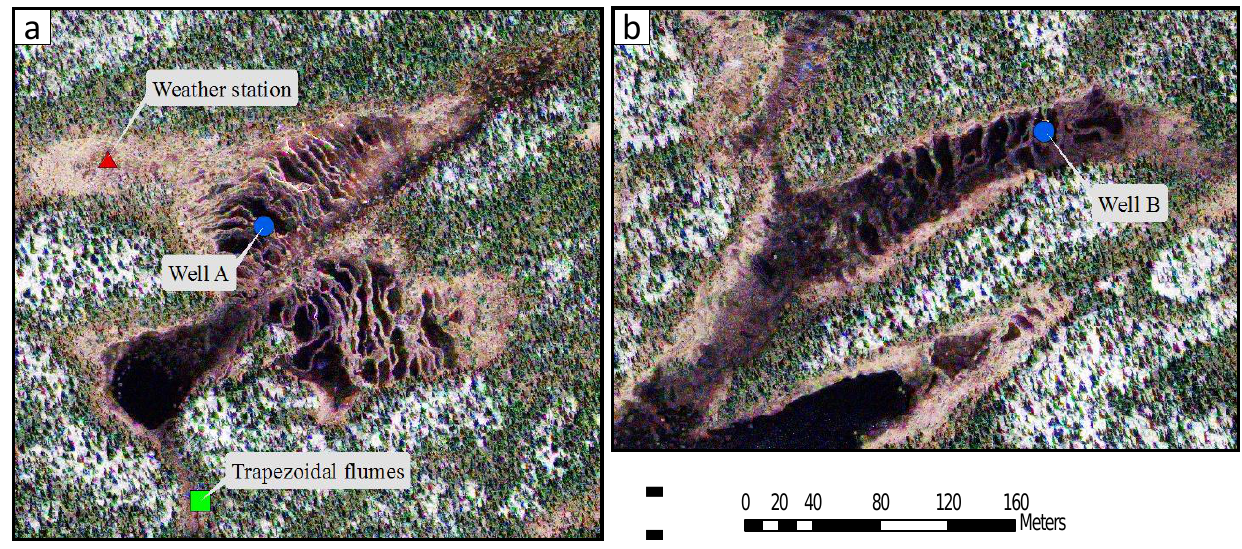
Figure 2. Location of the instruments used in the study at ( a ) site 1